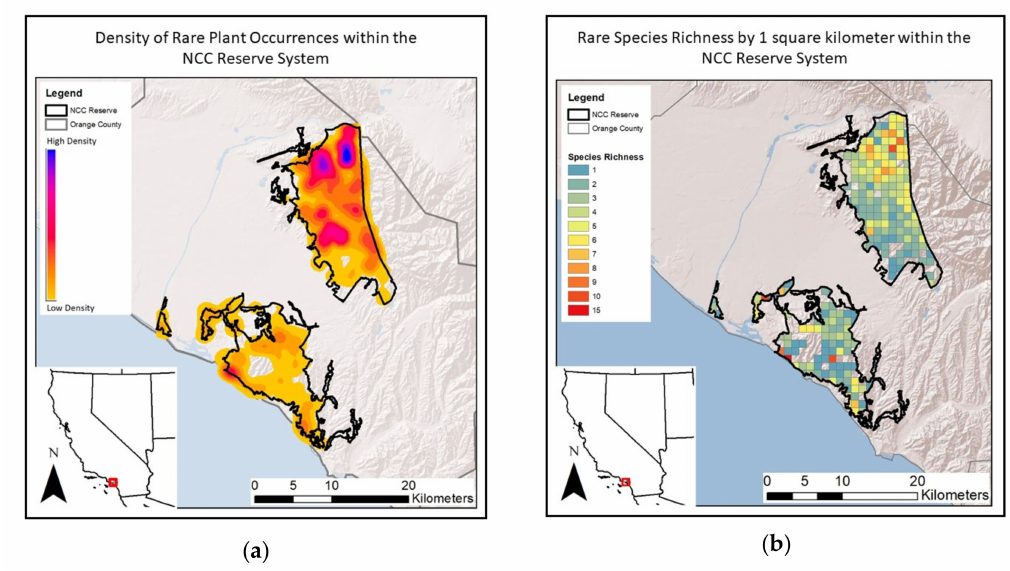
Figure 2. ( a ) The density of rare plant occurrences within the Natural Communities Coalition Reserve System. Blue indicates a higher density of rare plant occurrences, orange, and yellow indicates a lower density of occurrences. The NE corner of the Central reserve, in the top right corner of the map, has the highest density of occurrences within the Central reserve. ( b ) Rare plant species richness per 1 square kilometer within the Natural Communities Coalition (NCC) Reserve System. The warmer the color, the higher rare plant species richness. White squares indicate that there are no rare plant occurrences within that square km of the NCC black boundary. The coastal reserve contained areas that reached the maximum of 15 rare plants within 1 square